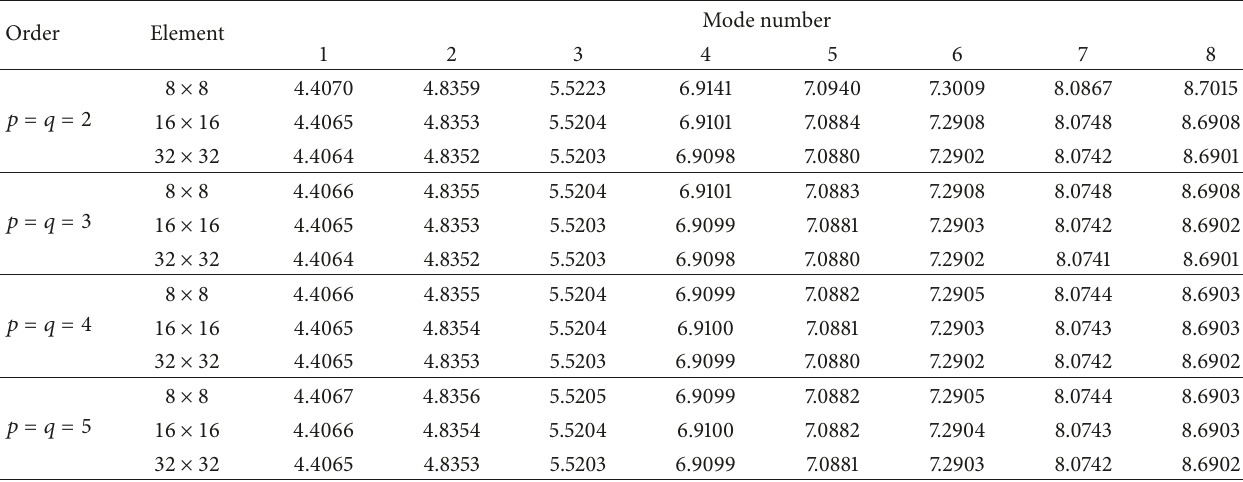
Table 1: Convergence of frequency parameters Ω = (2𝜔𝑅 1 /𝜋)√(𝜌/(𝐸(1 − ] 2 ))) Ω of plates with CCCC boundaries and inner-to-outer radii ratios: 𝑅 0 /𝑅 1 = 0.5 .